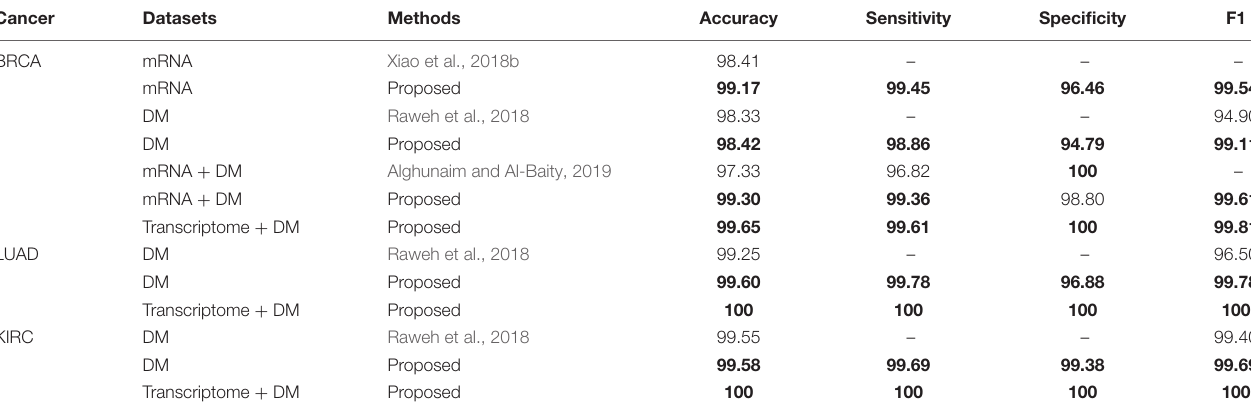
TABLE 4 | Comparison results with the state-of-the-art approaches (%). Cancer Datasets